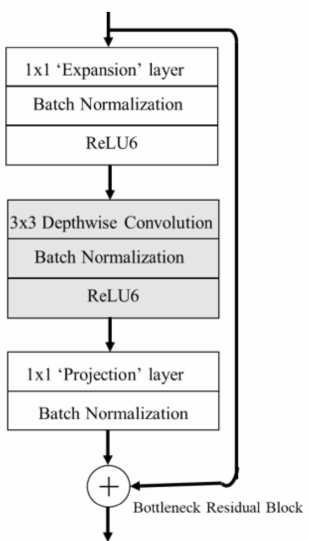
Figure 13. The architecture of MobileNet v2 [38].